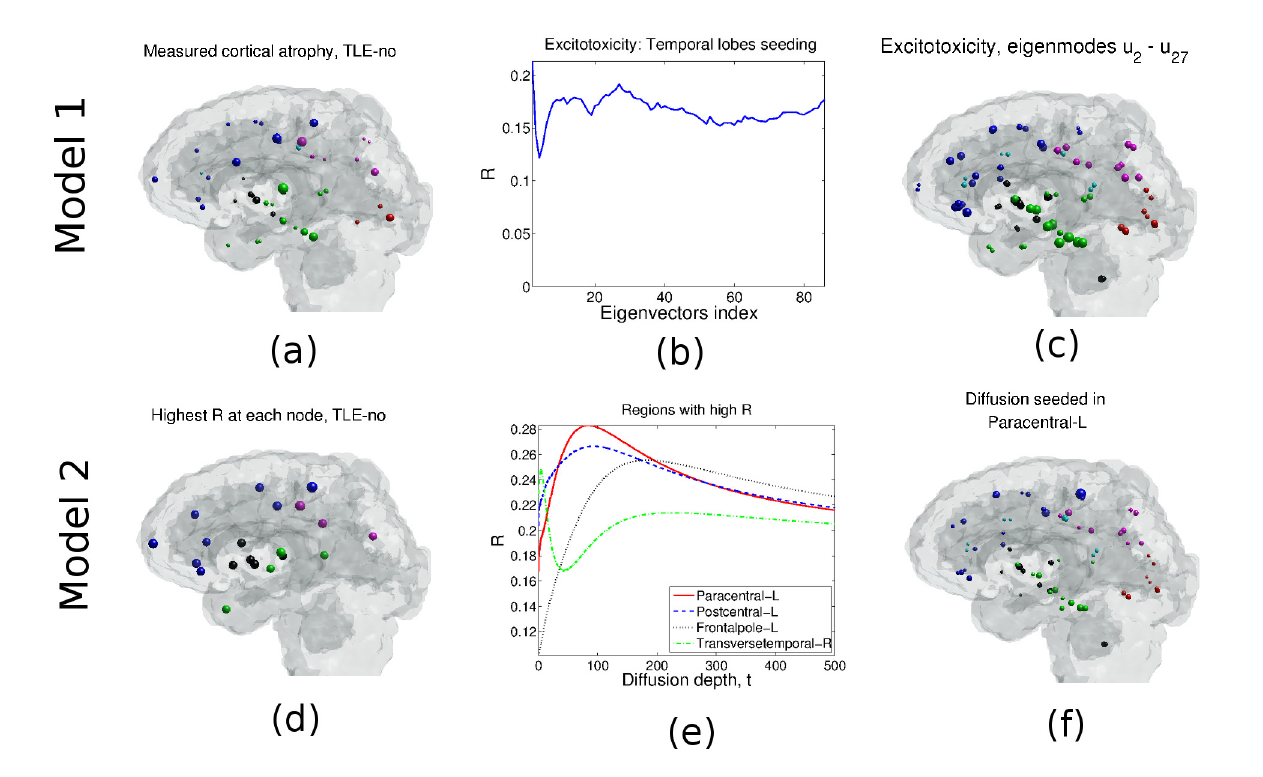
Fig 3. TLE-no case, Model 1: (a) Cortical/subcortical atrophy obtained from t -statistics of epileptic and healthy groups ’ volumetrics. (b) R vs. the number of eigen-modes Eq (10) used for neuronal atrophy estimation. (c) Atrophy distribution estimated using Model 1 and eigen-modes u 2 – u 27 . Model 2: (d) Correlation R of group atrophy and Φ 2 obtained when each node is seeded. (e) R vs. graph diffusion depth t . Left paracentral gives the maximum R , followed by the left post central and the left frontal pole. (f) Neuronal atrophy estimate obtained from Model 2 when the paracentral lobe is